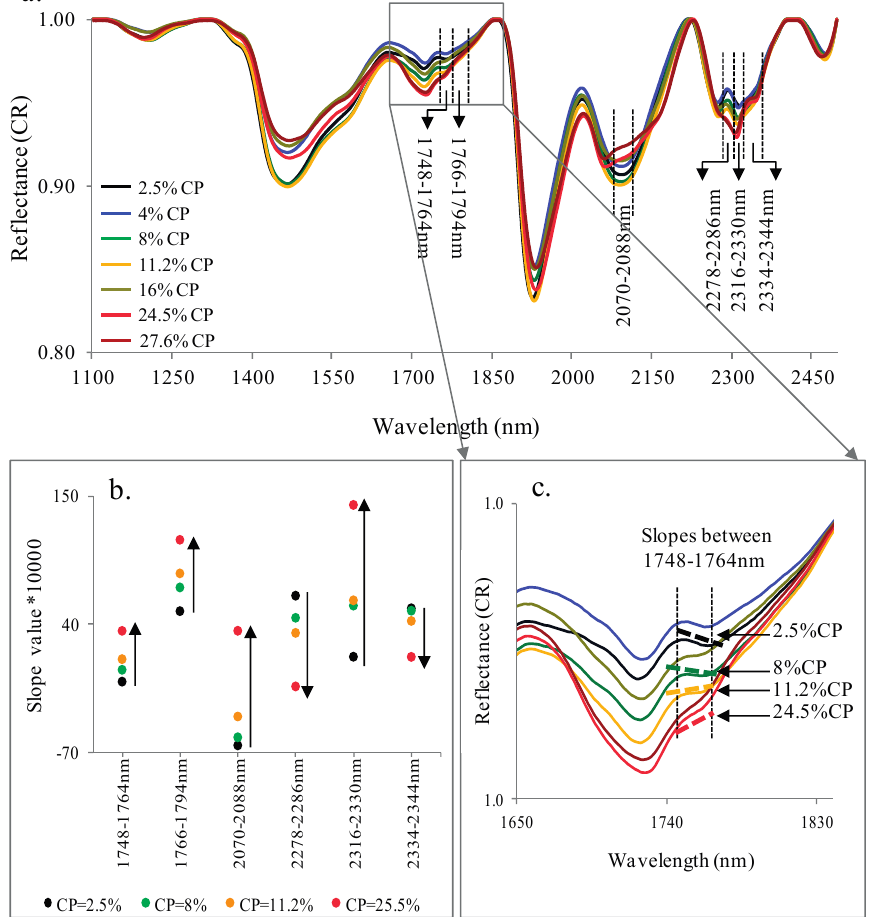
Figure 1. ( a ) Continuum removal (CR) reflectance spectra of vegetation samples with different percentages of crude protein (CP). Note the variability in the slopes across the different spectral ranges: 1748–1764 nm, 1766–1794 nm, 2070–2088 nm, 2278–2286 nm, 2316–2330 nm, 2334–2344 nm. ( b ) Visualization of the slope’s tendency to increase or decrease as a function of different CP contents. Up-pointing arrow indicates a slope increase with CP content increase; down-pointing arrow indicates a slope decrease with CP content increase. ( c ) Zooming in on the 1748–1764 nm spectral range to demonstrate the changes in the slope with changes in CP